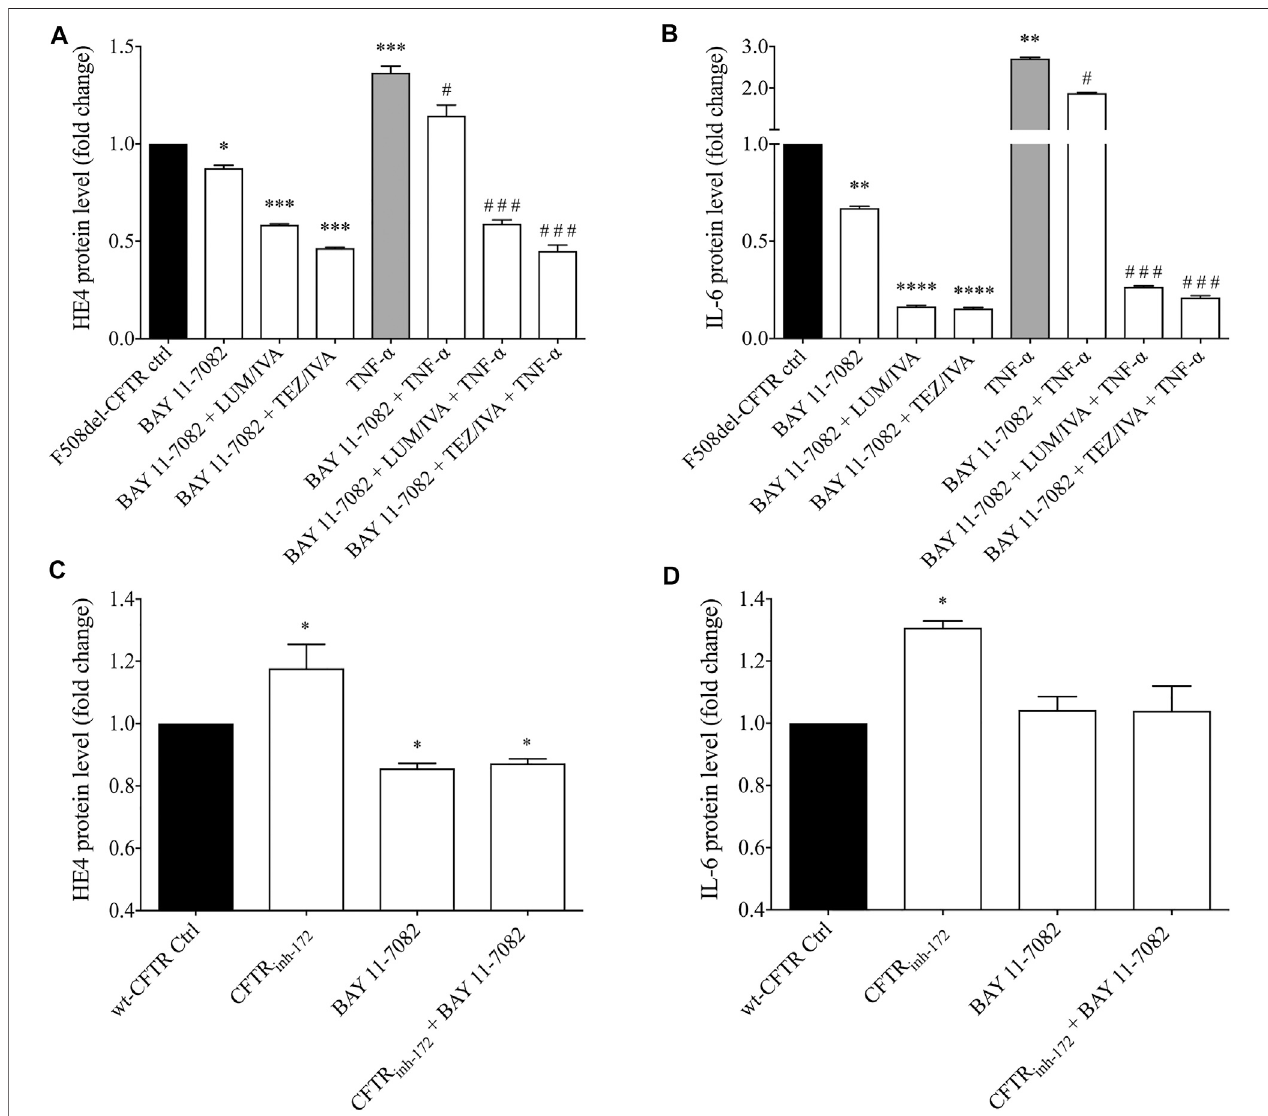
FIGURE7| MeasurementofHE4andIL-6concentrationsinnon-activatedandTNF- α activatedF508del-CFTRCFBE41o − cellsinthepresenceofNF- κ Bpathway inhibitor and CFTR modulators. BAY 11-7082 (5 μ M) was applied to attenuate NF- κ B-mediated in fl ammatory signaling in relation to basal and TNF- α induced HE4 expression in F508del-CFTR CFBE 41o − cells under LUM/IVA or TEZ/IVA or vehicle for 24 h. TNF- α -induced HE4 (A) and IL-6 (B) expression was prevented by BAY 11 – 7082,and aneven stronger decrease inHE4 and IL-6wasobservedwhen NF- κ Binhibitor and CFTRmodulatorswere administered together vs.sampleswith TNF- α and DMSO. When wt-CFTR CFBE 41o − cells were treated with CFTR inh172 with or without BAY 11-7082, CFTR inh172 (20 μ M) could not elevate HE4 level after incubationwithNF- κ Binhibitor suggestingtheroleofNF- κ BassociatedwithCFTR (C) ChangesinIL-6withthesametrendindicatesacloserelationshipbetweenCFTR functionandpro-in fl ammatoryconditionsinCF (D) Mean ± SEM,n (cid:2) 5 – 6samples/condition.* p < 0.05, ** p < 0.01, *** p < 0.001and **** p < 0.0001vs.controlsampleswith DMSO; # p < 0.05 and ### p < 0.001 vs. control samples with TNF- α and vehicle.